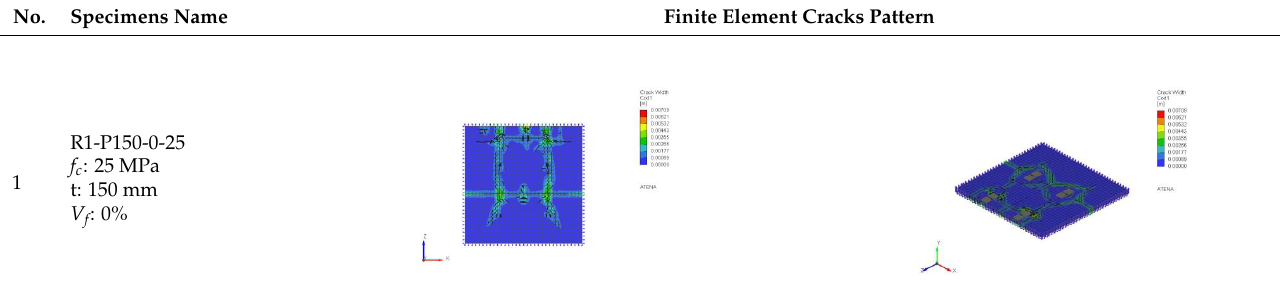
Table A2. Displays the finite element cracks pattern of the rigid pavement specimens .